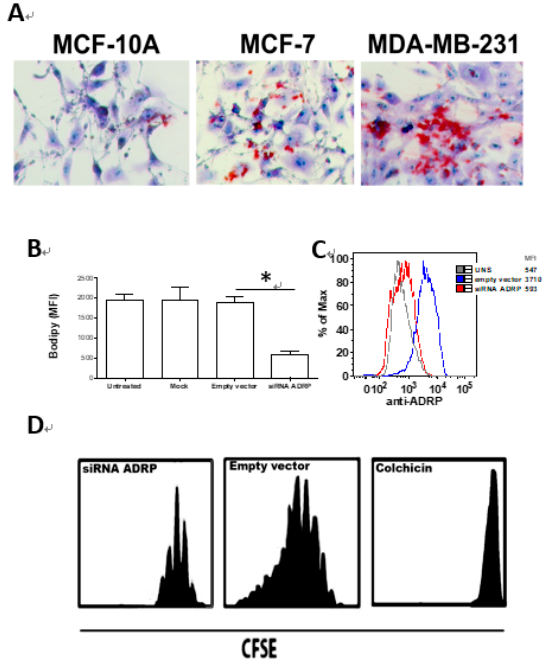
Figure 1. ( A ). Lipid droplet biogenesis in MCF-10A, MFC-7 and MDA-MB-231 was assessed by Oil Red O staining and analyzed by bright microscopy, magnification of 40×. ( B ). Lipid droplet biogenesis of MDA-MB-231 cells treated with siRNA for adipose differentiation-related protein (ADRP) silencing was assessed by Bodipy staining and analyzed by flow cytometry. ( C ). ADRP expression of MDA-MB-231 cells treated with siRNA for ADRP silencing was assessed by immunostaining of cells with anti-ADRP and analyzed by flow cytometry, numbers represent mean fluorescence intensity (MFI), statistical significance is represented by an asterisk with p < 0.05. ( D ). Cell proliferation of MDA-MB-231 cells treated with siRNA for ADRP silencing was assessed by Carboxyfluorescein Succinimidyl Ester (CFSE) staining and analyzed by flow cytometry. Histograms are representative of three independent experiments.